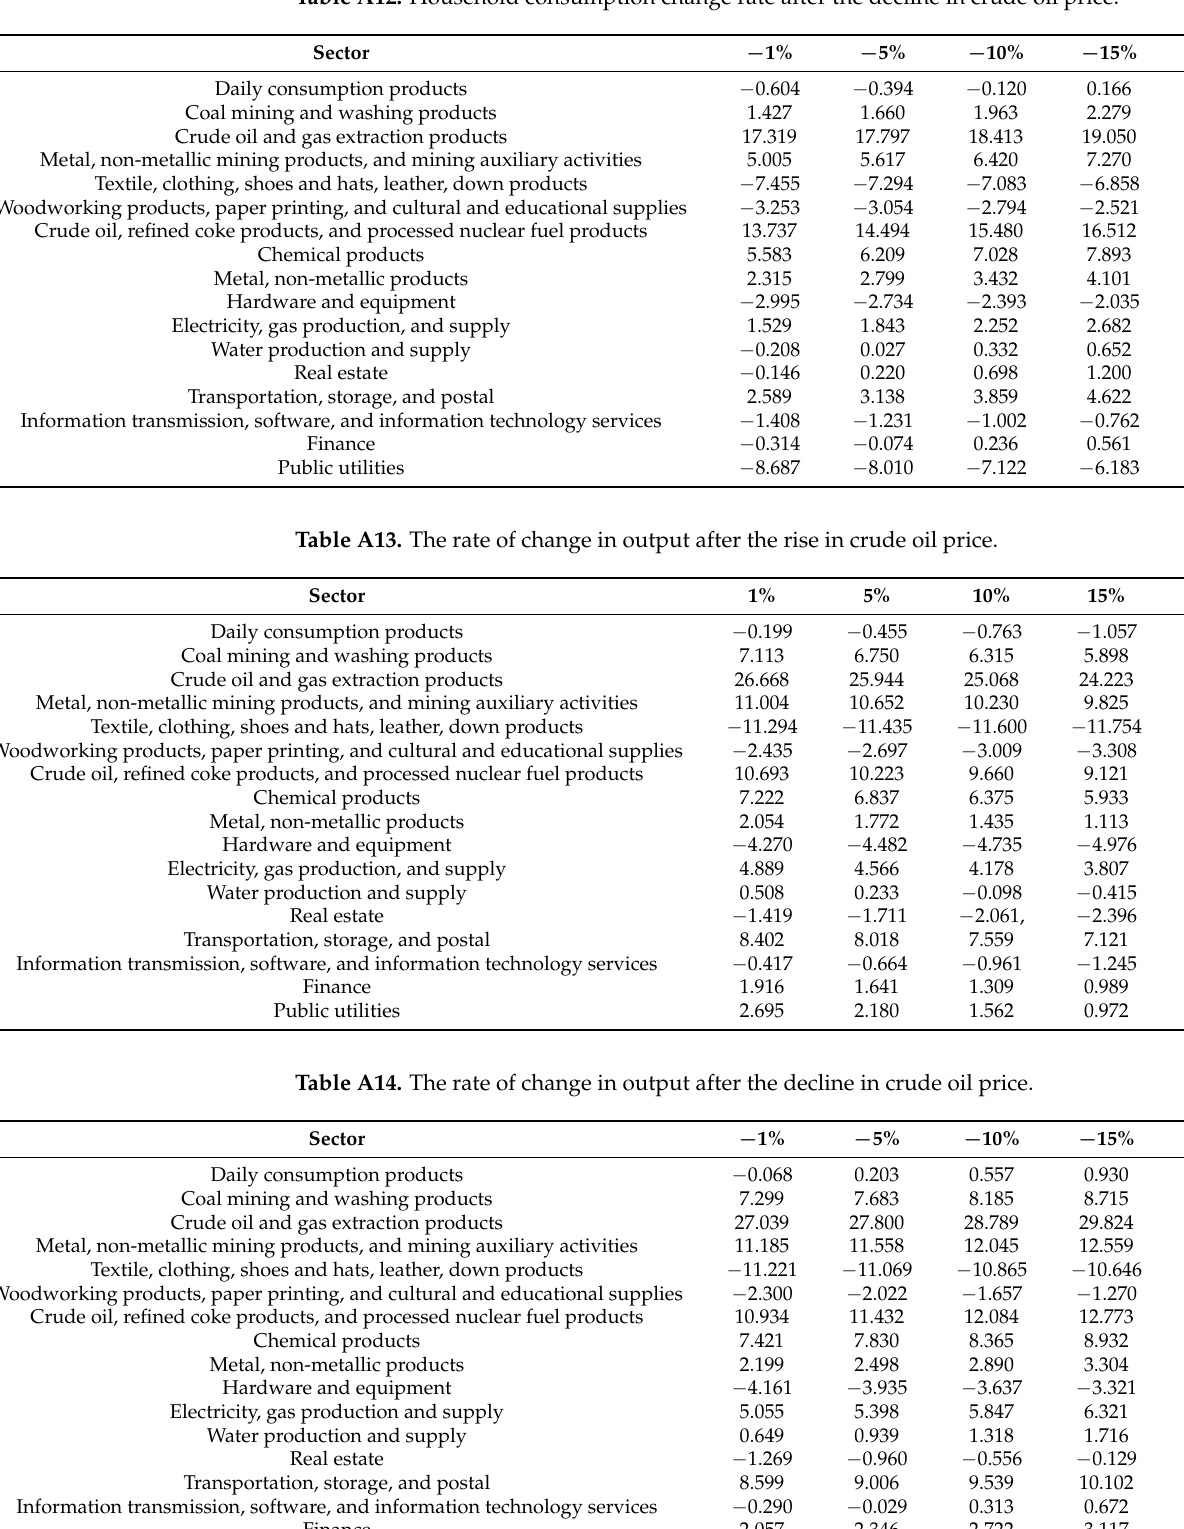
Table A12. Household consumption change rate after the decline in crude oil price.